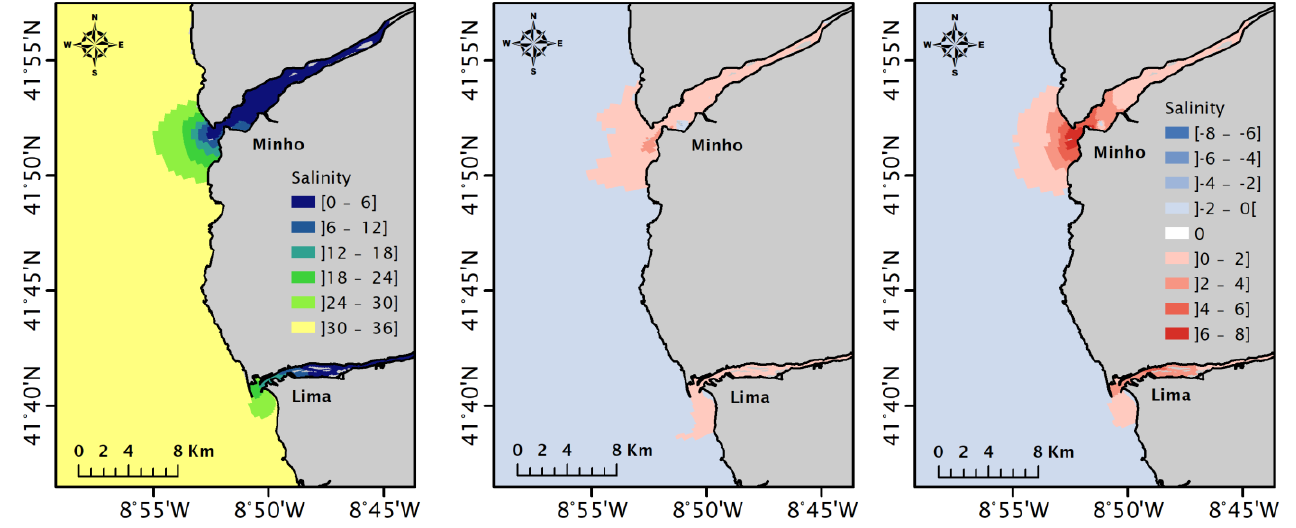
Figure 7. Estuarine plume during winter conditions. The left map represents the average saline distribution for the Present scenario, and, the centre and right maps the differences between the RCP 4.5/RCP 8.5 scenarios and the Present scenario, respectively.